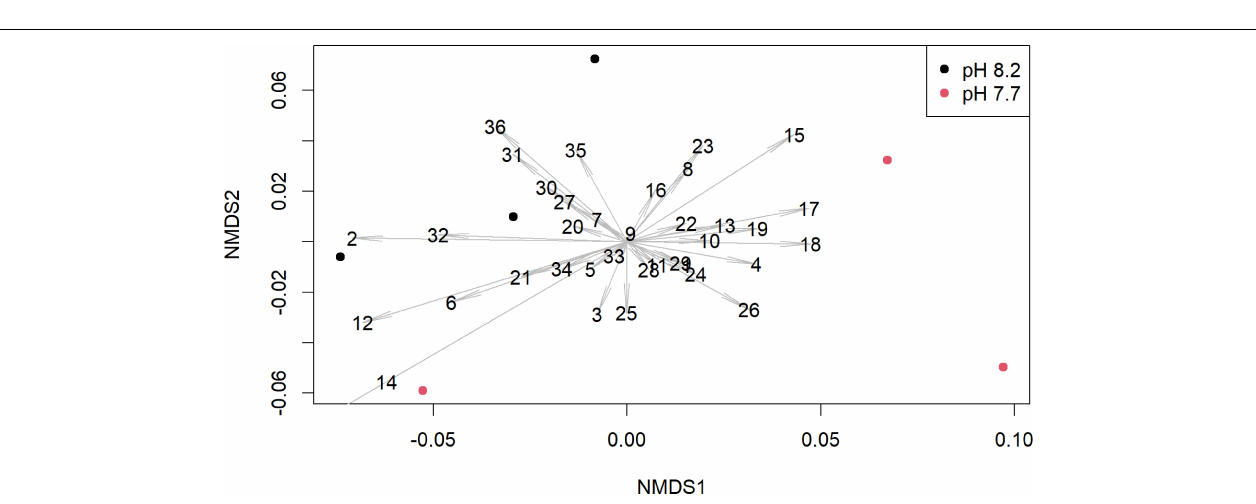
FIGURE 3 | Non-metric multidimensional scaling (NMDS) plot of the abundance of volatile organic compounds (VOCs) normalized to internal standard from Diploneis sp. depending on culture pH level. Dots indicate independently replicate and separately analyzed cultures of the same algal isolate, distances between dots indicate Bray-Curtis dissimilarities, arrow lengths indicate the contribution of the respective peak to the dissimilarity, numbers indicate the peak-identities (see Supplementary Table 5